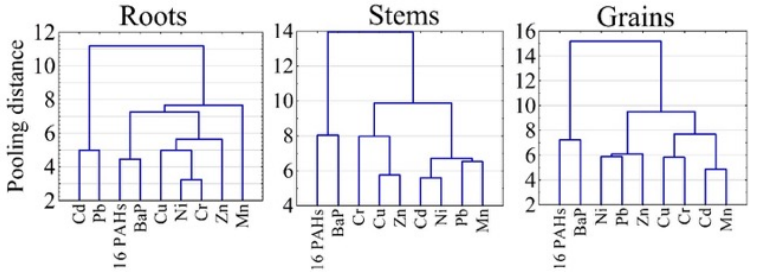
Figure 6. Clustering of pollutants in di ff erent parts of the plant over a 10-year monitoring period.